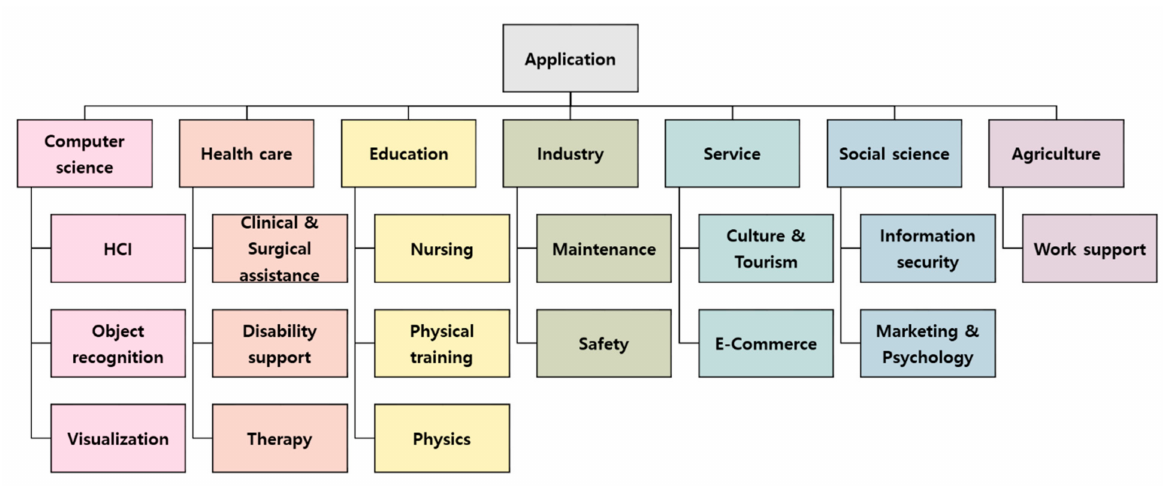
Figure 4. Structure of applied research fields and